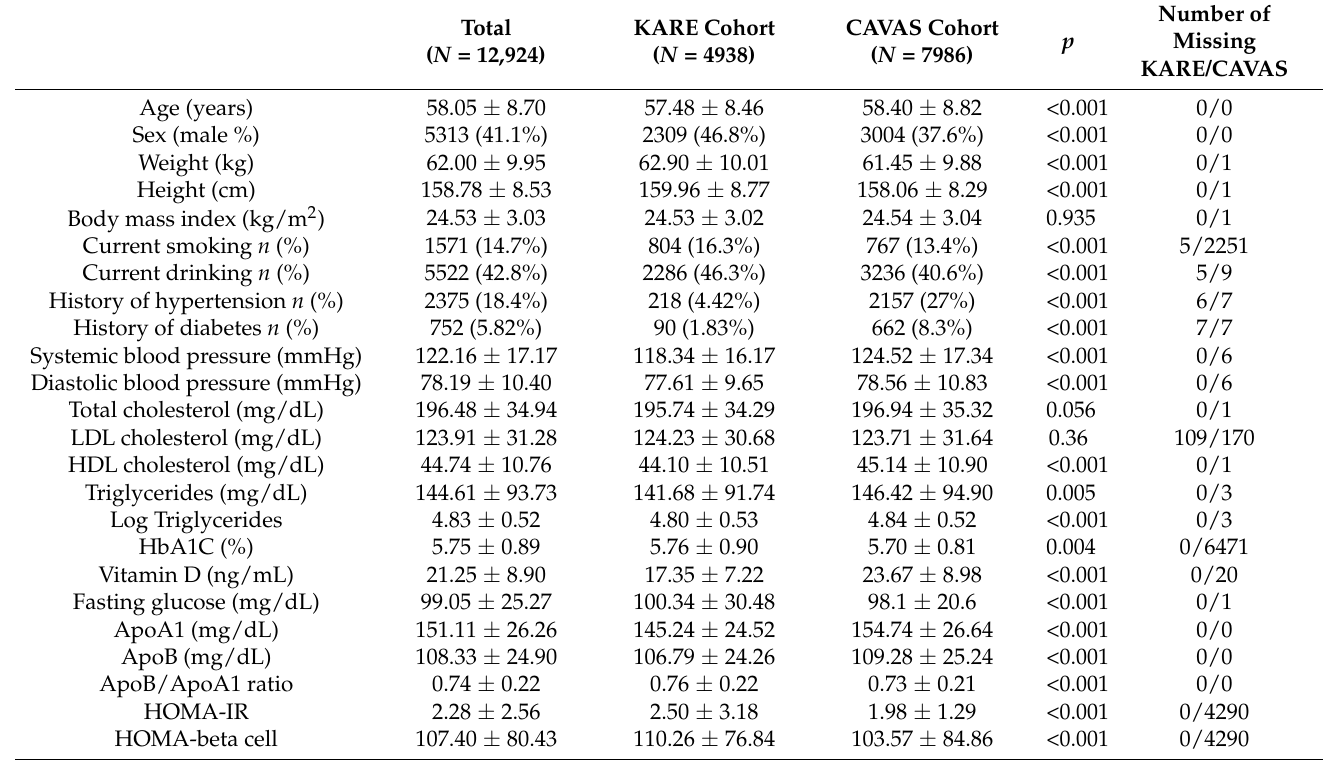
Table 1. Baseline characteristics of the study population.